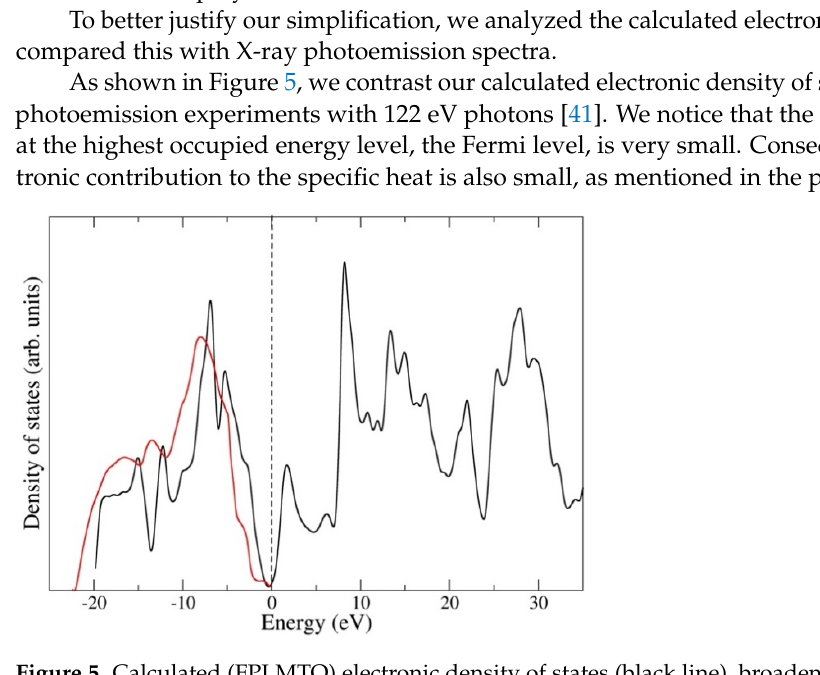
Figure 5. Calculated (FPLMTO) electronic density of states (black line), broadened with a 20 mRy Gaussian, together with X-ray photoemission spectra with 122 eV photons (red line) [41]. The Fermi level is at zero energy, and it is indicated with a vertical dashed line.